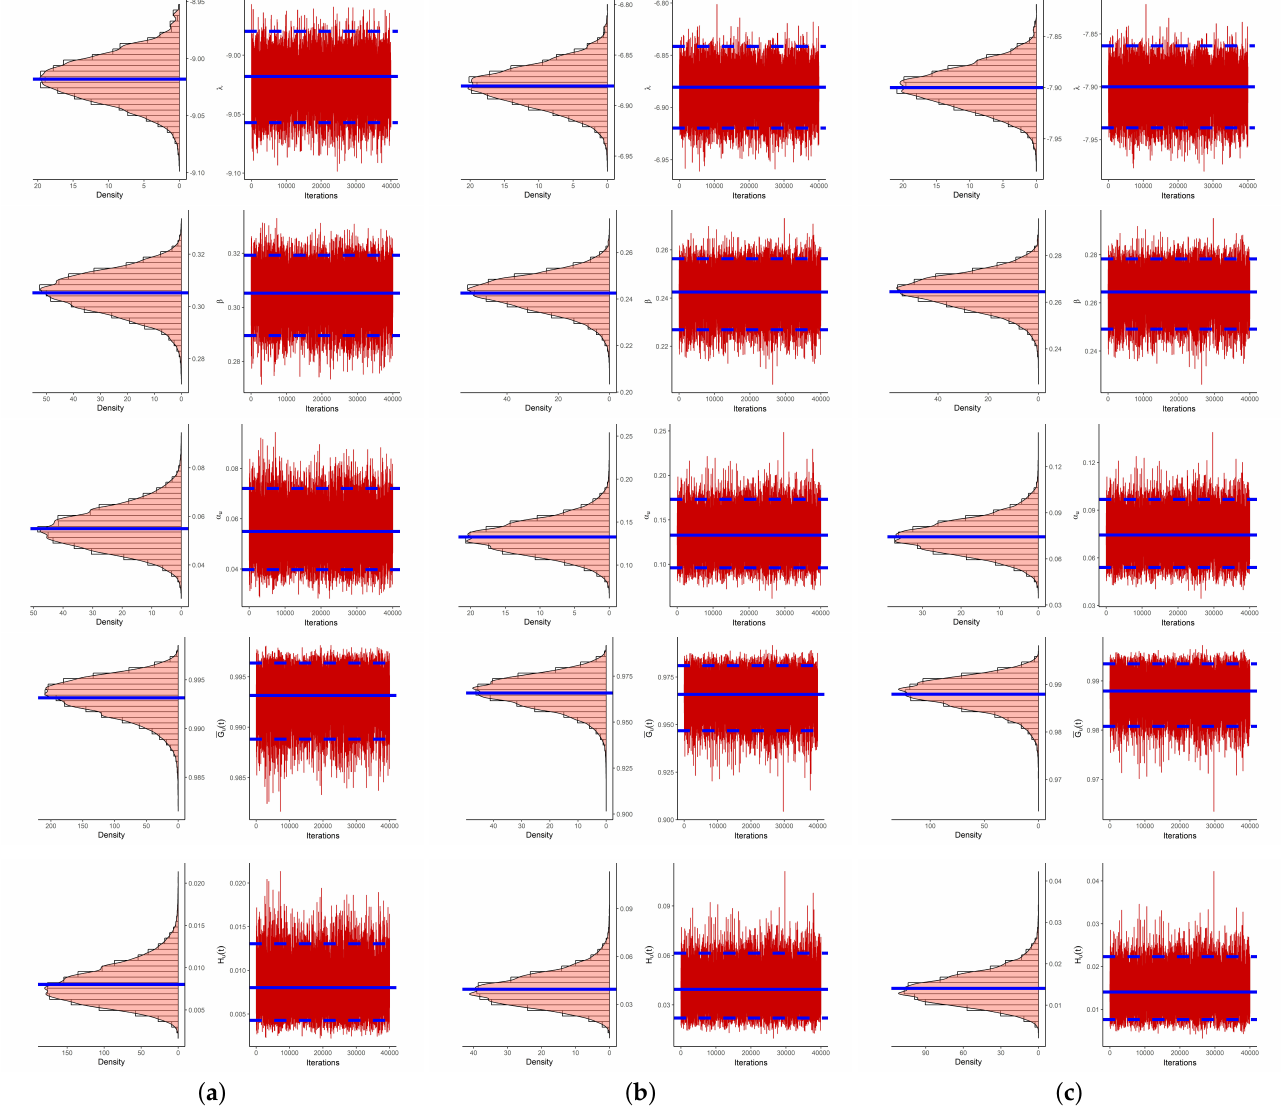
Figure 10. Density ( left ) and trace ( right ) plot of λ , β , α u , G u ( t ) and H u ( t ) from TLT data. ( a ) Sample 1; ( b ) Sample 2; ( c ) Sample 3. Table 5. Various constant stress PC-T-II samples from TLT